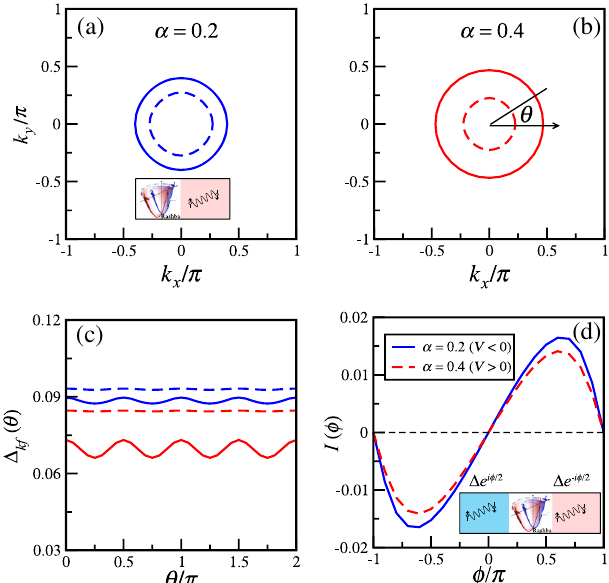
FIG. 3. (a) Fermi surface for TB with α ¼ 0 . 2 . The inset illustrates the proximity process leading to the pairing amplitude in (c). (b) Fermi surface for TB with α ¼ 0 . 4 . (c) Spin-singlet pairing strengths along each FS for α ¼ 0 . 2 , 0.4. θ is the angle along each FS as defined in (a) and (b). (d) The Josephson currents I ð ϕ Þ in unit of 2 e= ℏ for the Rashba JD for α ¼ 0 . 2 and α ¼ 0 . 4 and the inset shows the setup for calculating the current. The other parameters are set as t R ¼ t L ¼ 1 . 0 , Δ 1 ¼ Δ 2 ¼ 0 . 2 , ¼ 0 . 8 , t ¼ 0 . 6 , and μ ¼ − 3 . 0 . In the calculation, we set the t RB LB thickness of SC on both sides to be